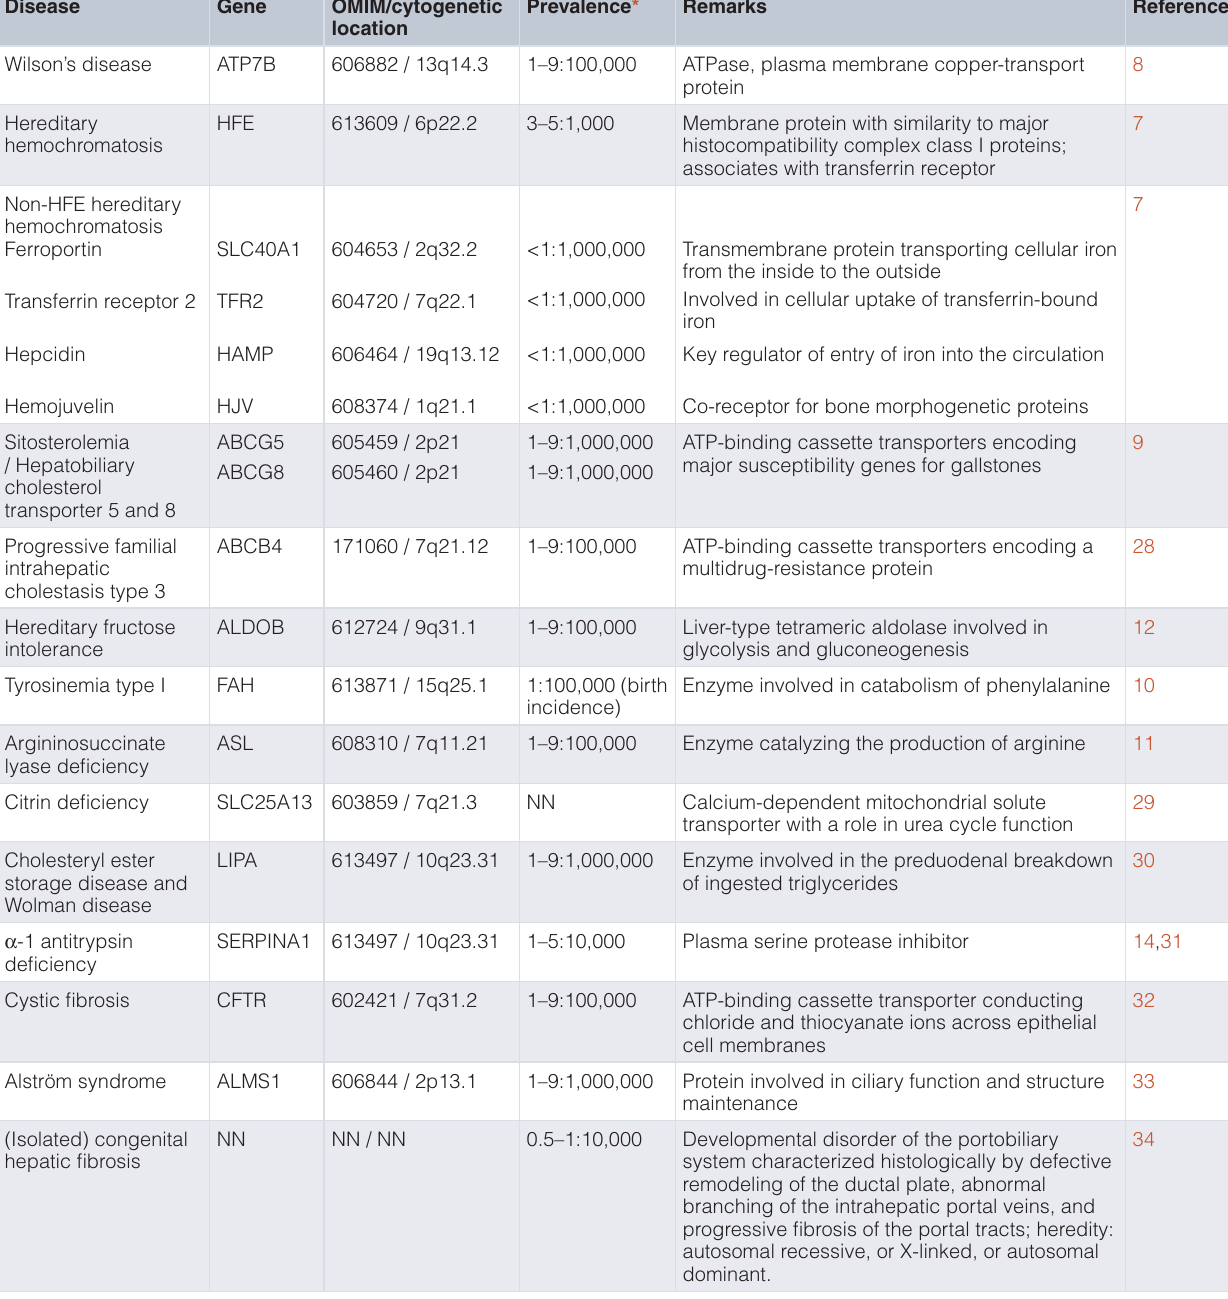
Table 1. Selected inherited disorders associated with hepatic fibrosis.